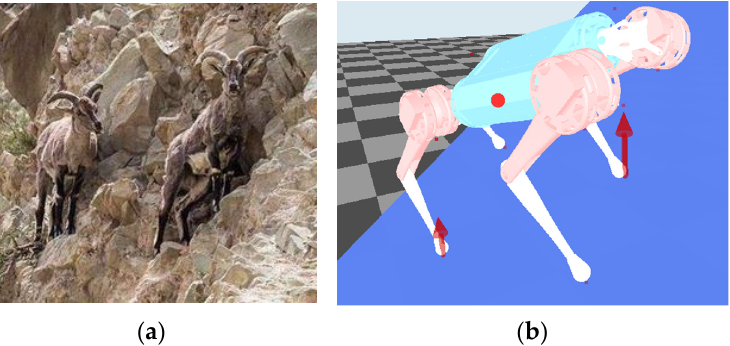
Figure 1. The uphill posture of blue sheep and the quadruped robot (under our adaptive algorithm). ( a ) Walking posture of blue sheep; ( b ) Walking posture under